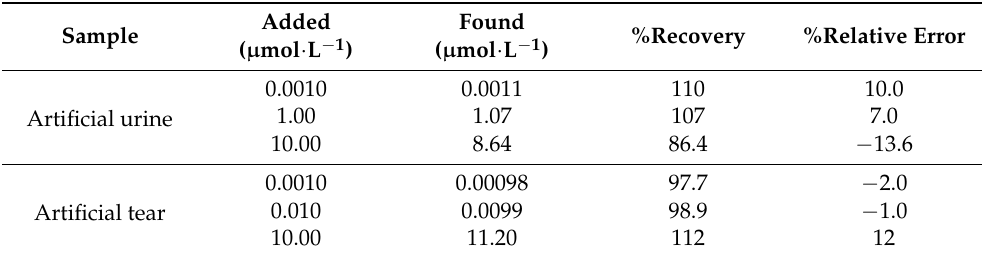
Table 2. Result of recovery studied of glucose in tear solution and an artificial human urine.